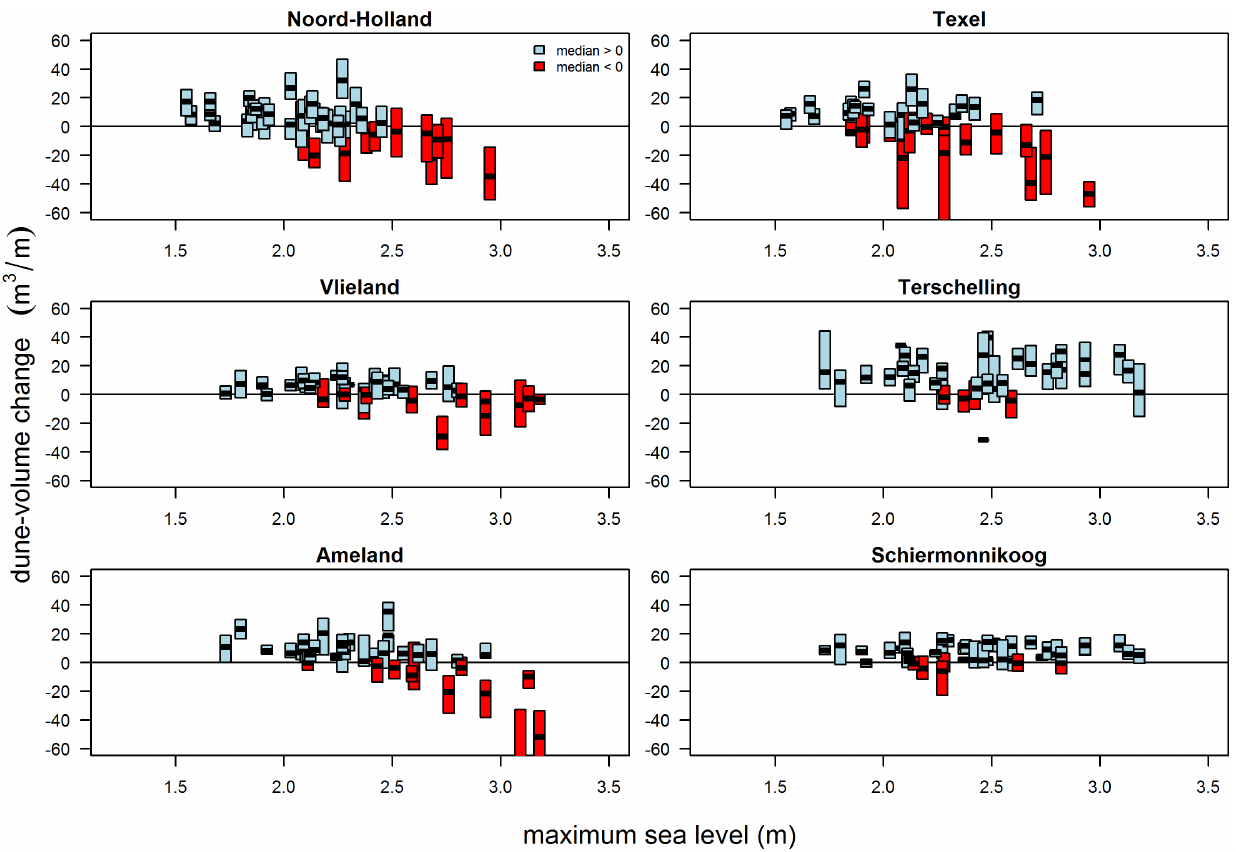
Figure 6. Dune-volume changes ( D V) as a function of maximum sea level (S) for all sites. Each boxplot represents the longshore variation for a single year. Boxplots with a positive median in blue, with a negative median in red.